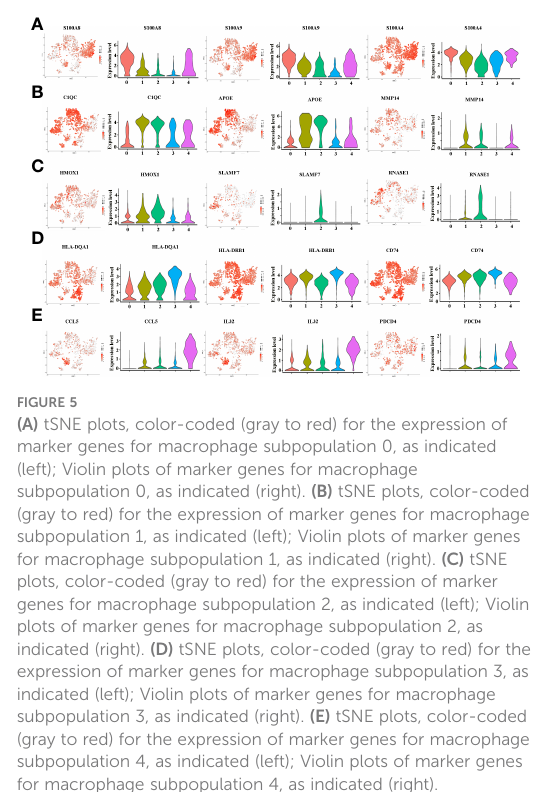
Cluster 0: S100A + macrophages ( Figure 5A ) , Cluster 1: C1QC + macrophages ( Figure 5B ) , Cluster 2: FCGR3A + macrophages ( Figure 5C ) , Cluster 3: HLA + macrophages ( Figure 5D ) and Cluster 4: CCL5 + macrophages ( Figure 5E ). All the differentially expressed marker genes in each cluster are shown in Supplementary Table 3. Based on the marker genes, we